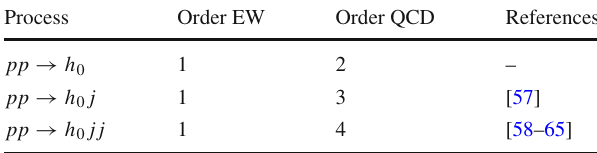
Table 2 Processes available in the Higgs